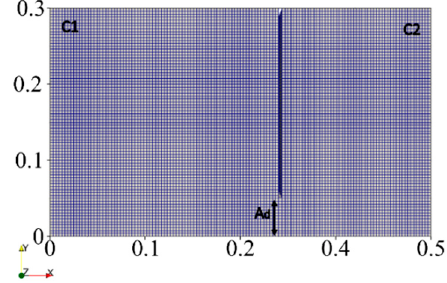
Figure 6. Numerical domain and mesh of the validation case.